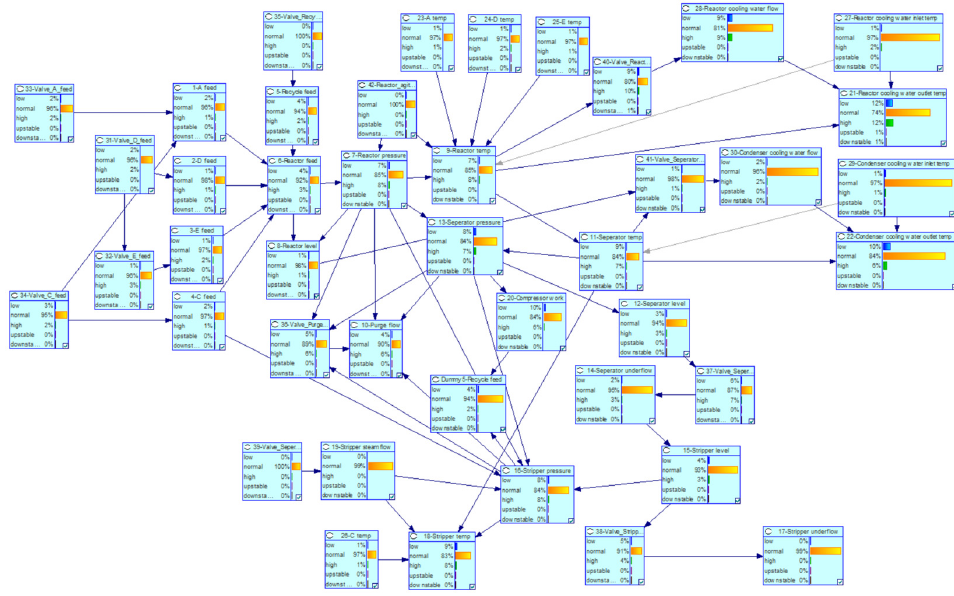
Figure 9. The structure of FSBN